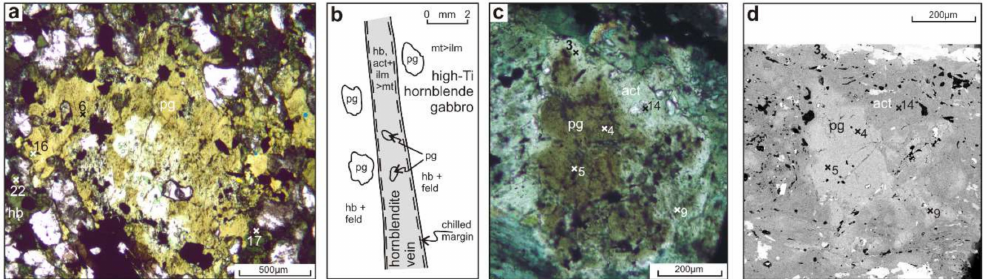
Figure 6. Petrographic microscope photomicrographs of amphiboles from a high-Ti hornblende gabbro (sample 3150). act: actinolite, feld: feldspar, hb: hornblende, ilm: ilmenite, mt: magnetite, pg: